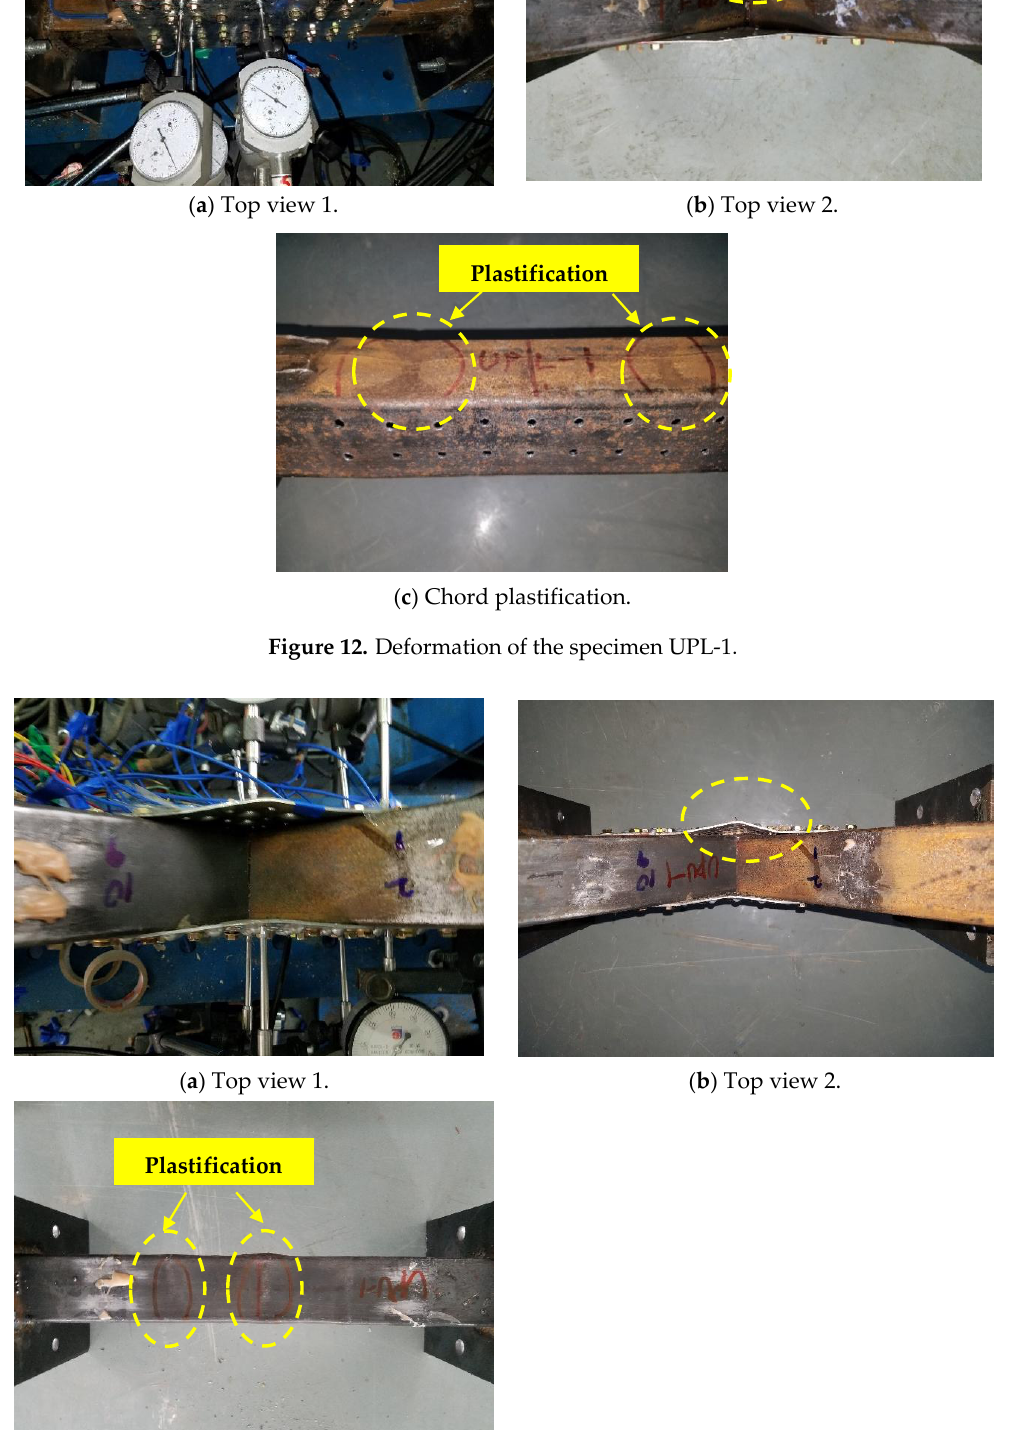
Figure 13. Deformation of specimen UPU-1.